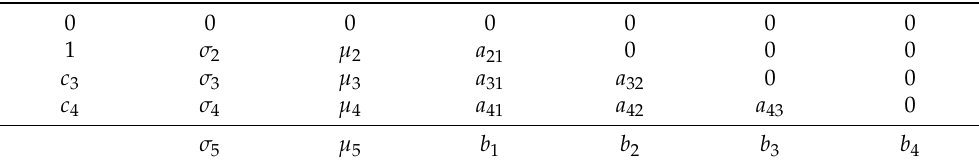
Table 1. Coefficients of a class of four-stage explicit hybrid methods defined in